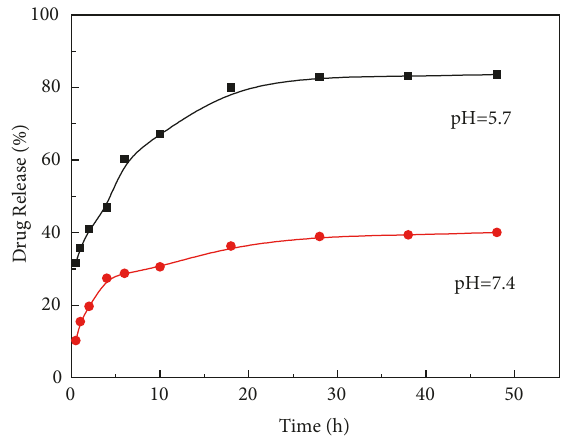
Figure 8: Natural logarithm of the release fraction of drug as a function of ln 𝑡